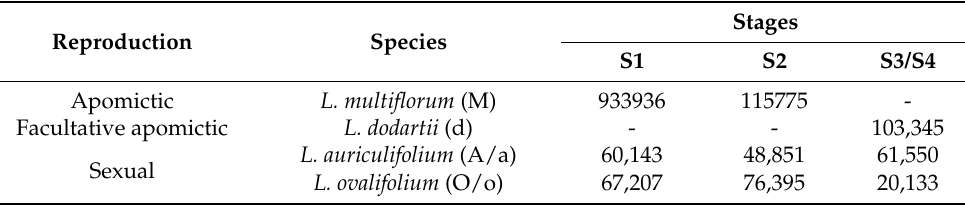
Table 2. Total number of genes expressed by Limonium samples from apomictic L. multiflorum (M), facultative apomictic Limonium dodartii (d), and sexual L. auriculifolium (A/a) and L. ovalifolium (O/o) ovules in stages S1, S2, and